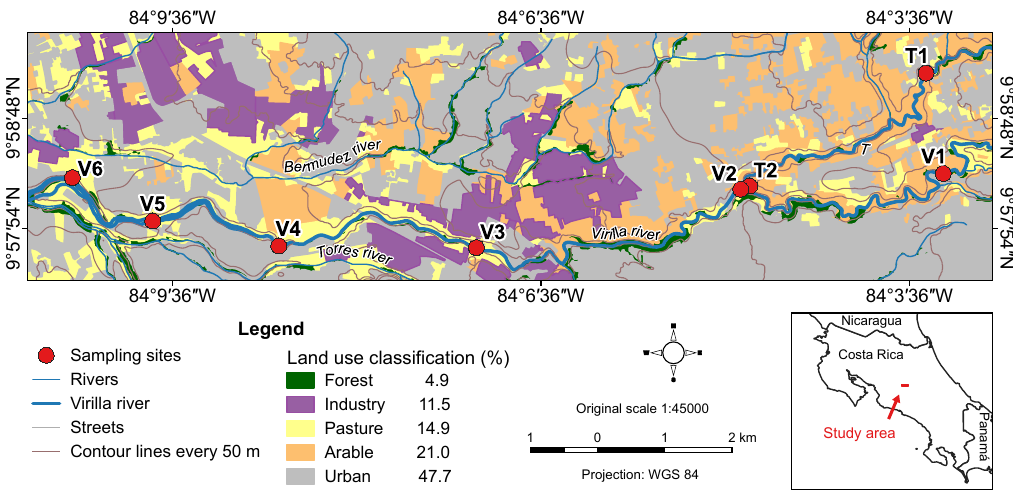
Figure 1. Study area in the Virilla river sub-catchment: including sample sites and land